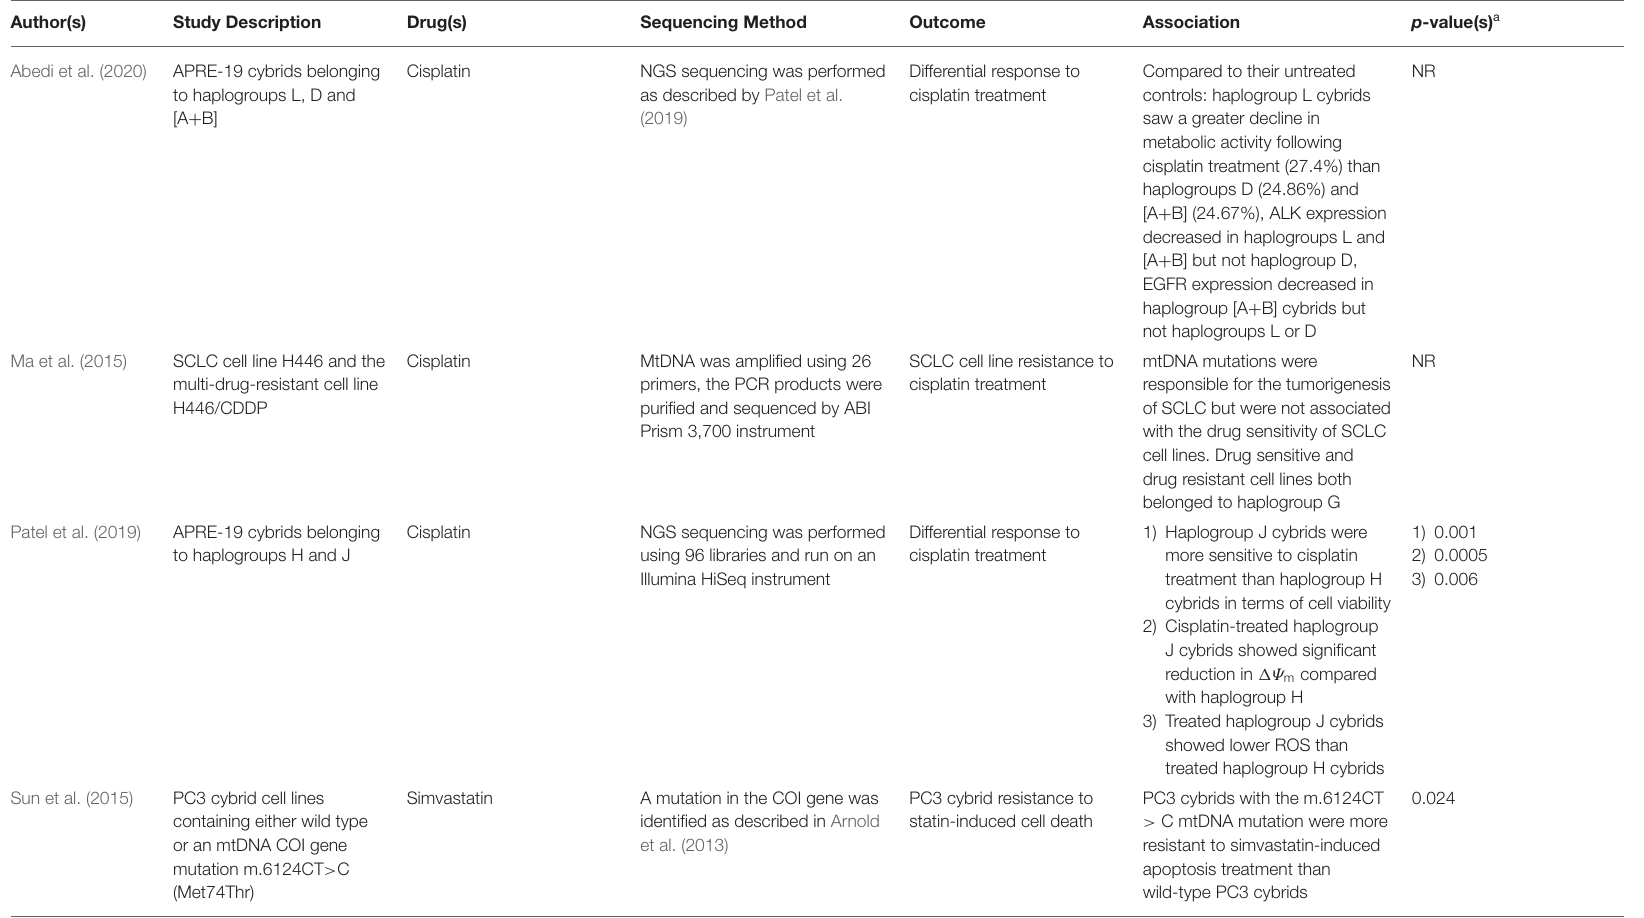
Abstraction table details the author(s), study design, drug(s) of interest, sequencing methods, outcomes, associations and statistics. a Odds ratio and 95% confidence intervals were unavailable for these articles. ALK, anaplastic lymphoma receptor tyrosine kinase; COI, cytochrome c; cybrid, cytoplasmic hybrid; 1Ψ m, mitochondrial membrane potential, D-loop, displacement loop; EGFR, epidermal growth factor receptor; mtDNA, mitochondrial DNA; NGS, next-generation sequencing; NR, not reported; PCR, polymerase chain reaction; ROS, reactive oxygen species; SCLC, small cell lung